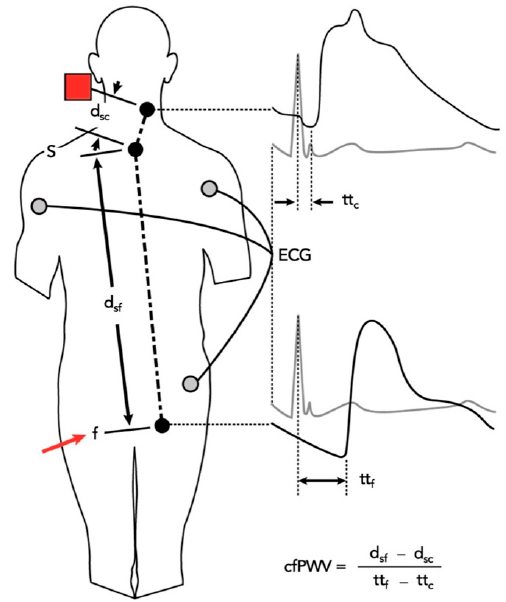
Figure 5. Schematic representation of SphygmoCor CvMS carotid-femoral pulse wave velocity (cf- PWV) measurement method with sequential applanation tonometry of the carotid (marked as a red square) and femoral (marked as a red arrow) sites. Pulse transit times (tt) are calculated from the electrocardiogram (ECG) R-wave to the foot of the applanated waves. Distances (d) are measured from the suprasternal notch (s) to the sites of applanation tonometry. Modified from Butlin and Qasem, 2016; © 2016 by S. Karger AG, Basel [60].